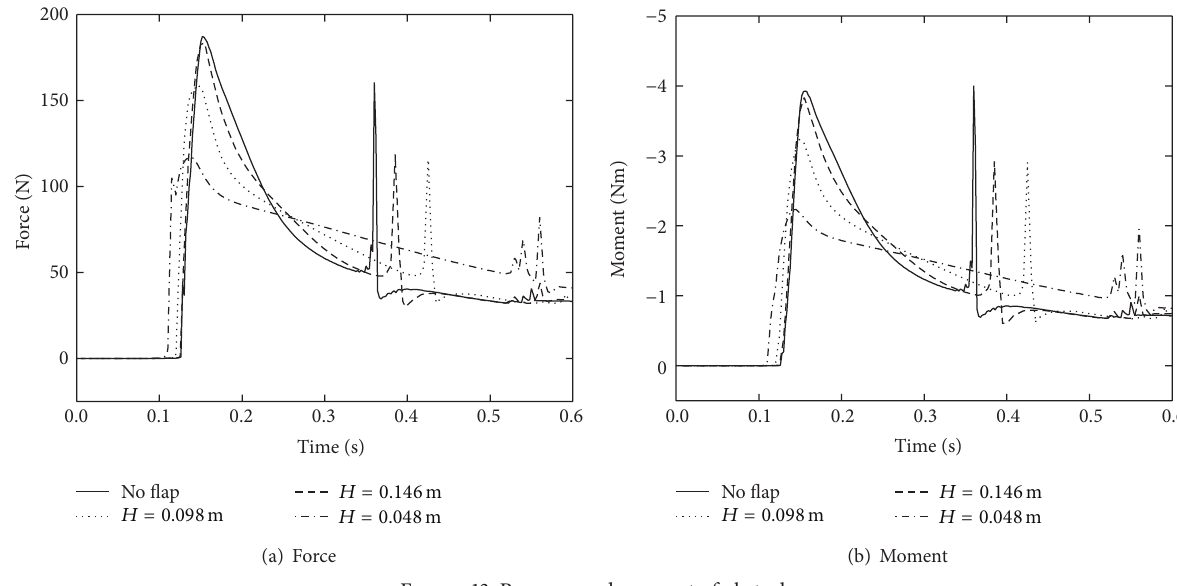
Figure 13: Pressure and moment of